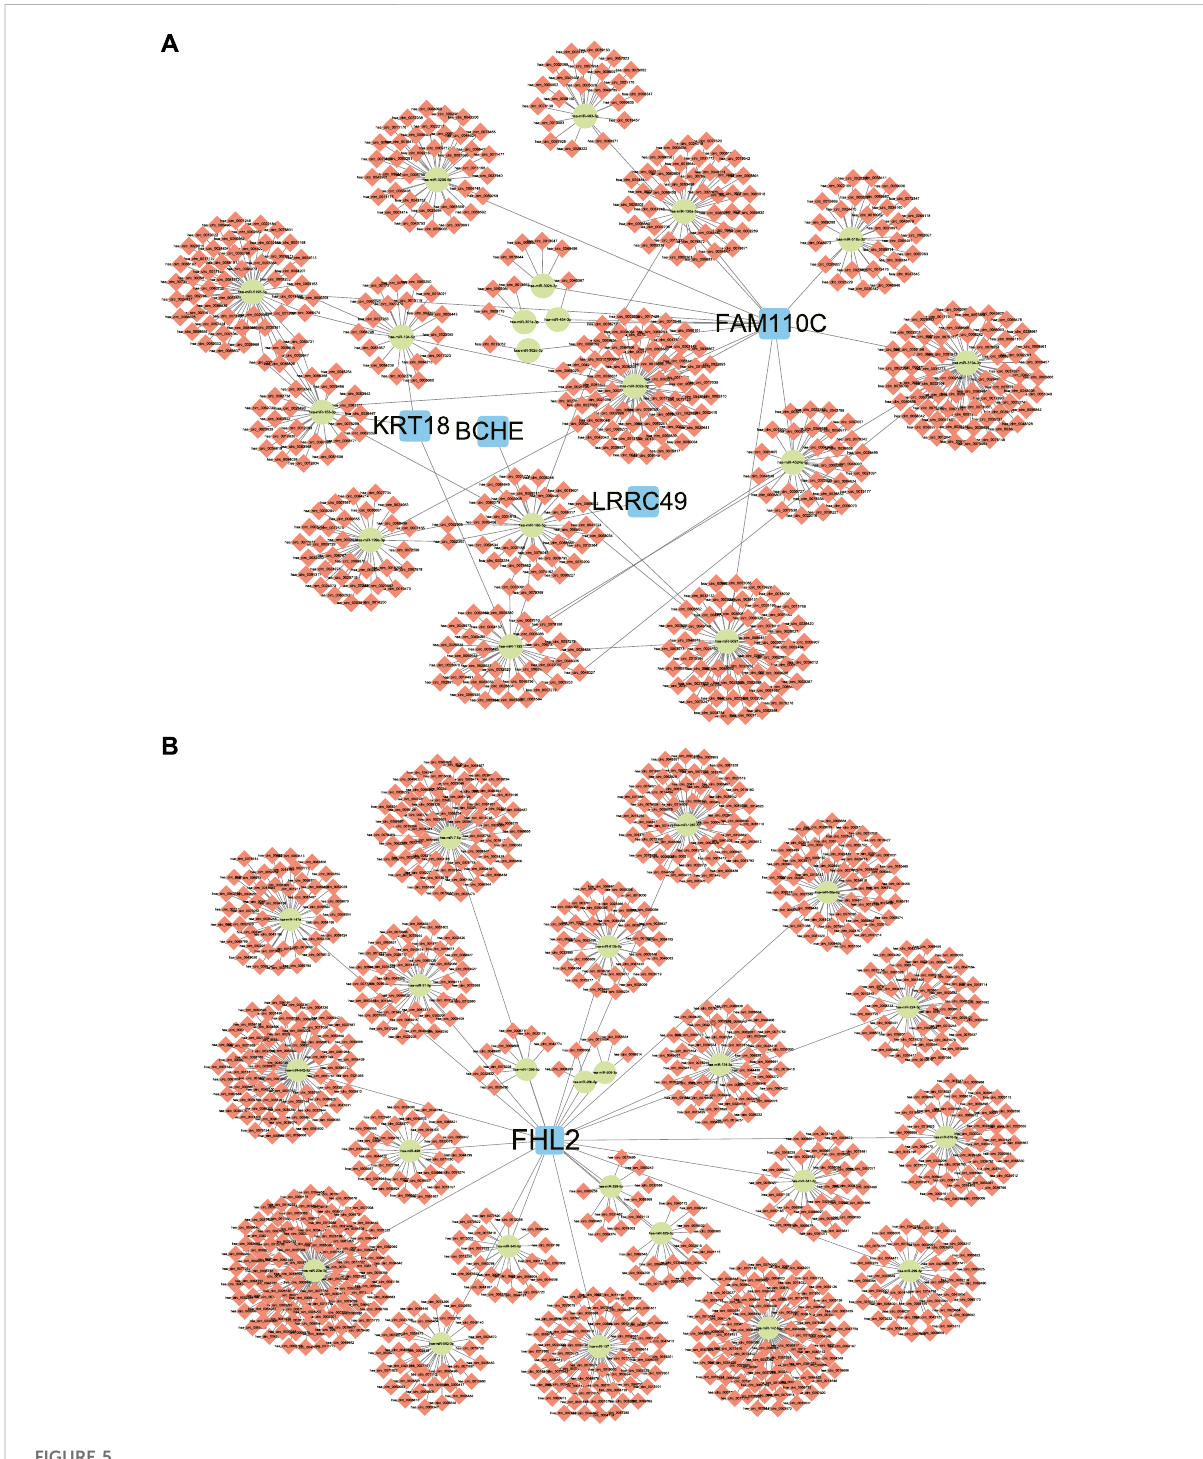
FIGURE 5 ceRNA networks of DEGs. (A) The ceRNA networks of downregulated DEGs. (B) The ceRNA networks of upregulated DEGs, FHL2. ceRNA: competing endogenous RNA, DEGs: differentially expressed